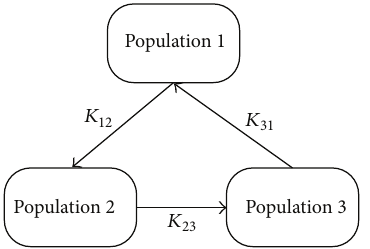
Figure 4: A regular network of three coupled neural populations.